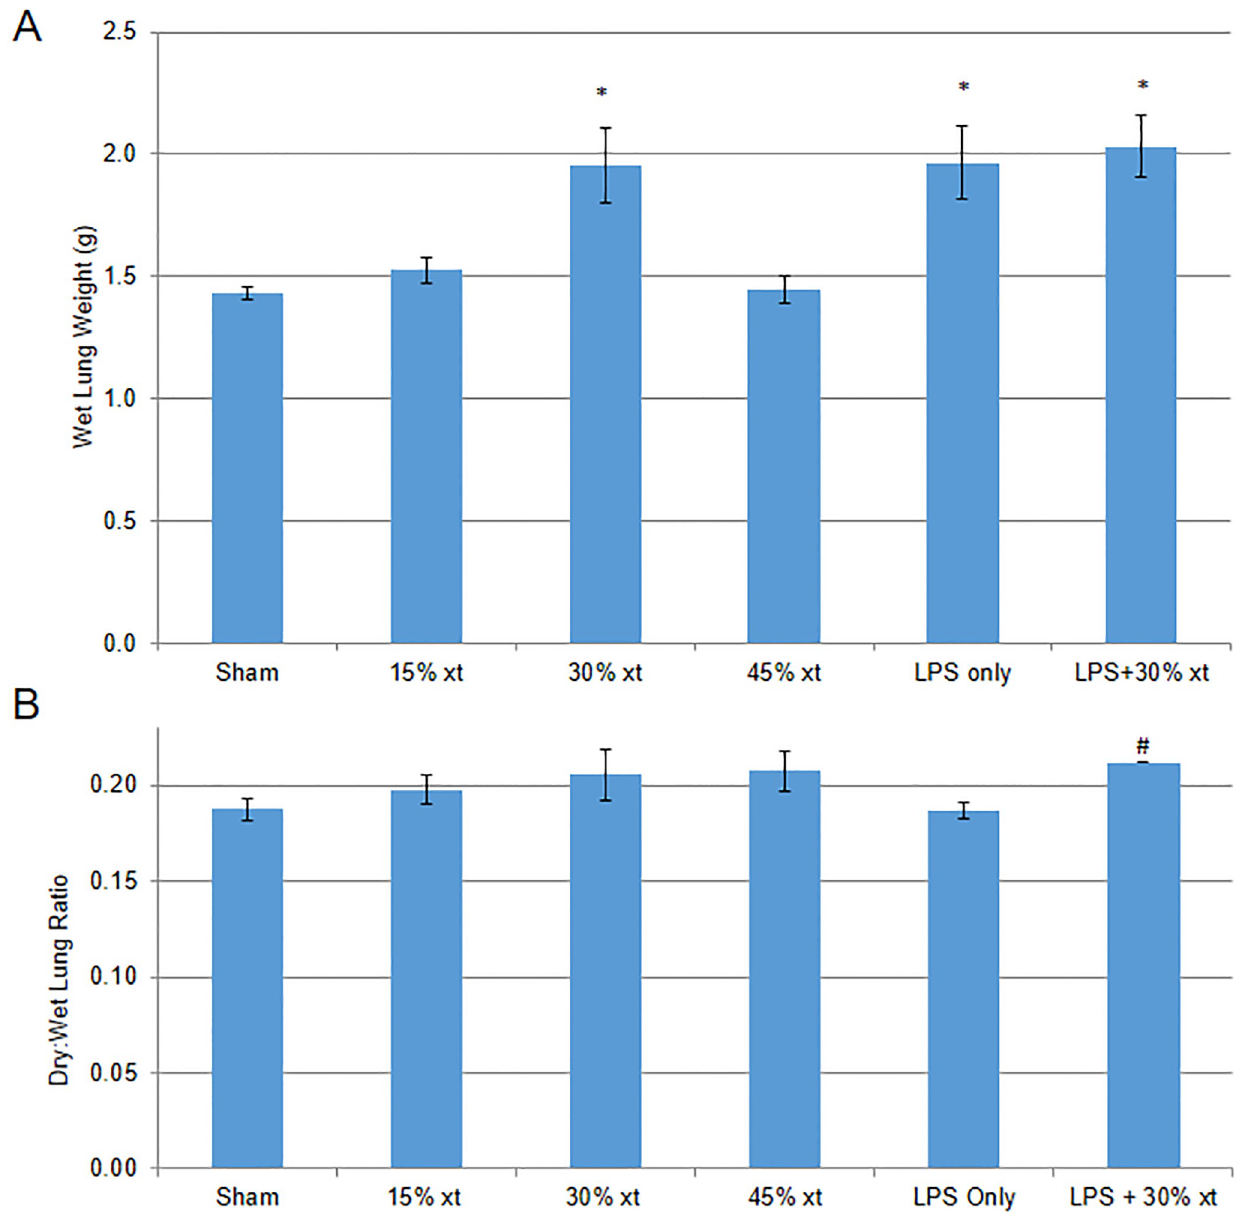
Fig 6. Thirty percent erythrocyte transfusion with LPS treatment increases lung weight. (A) Gross lung weights measured for sham animals (n = 6), rats receiving 15 (n = 3), 30 (n = 6) or 45% (n = 3) human erythrocyte transfusion (xt), LPS only (n = 7) or LPS+30% (n = 11) transfusion. (B) Wet and dry weights measured for sham animals (n = 8), rats transfused with 15 (n = 2), 30 (n = 3) or 45% (n = 3) human erythrocyte transfusion (xt), LPS only (n = 3) or LPS+30% (n = 3) transfusion and expressed as dry to wet ratio. Data are means and standard error of the mean. Statistical analysis was performed using an ANOVA followed by Student t -test. � denotes P < 0.01 compared to the sham. # denotes P < 0.05 compared to LPS